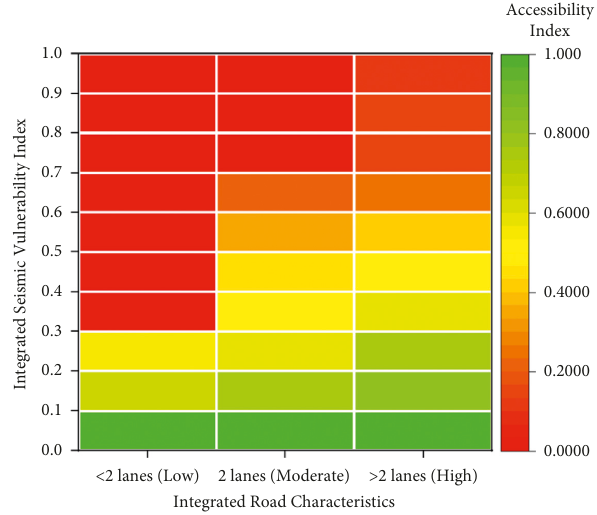
Figure 20: Generated accessibility heat map between integrated road characteristics and integrated seismic vulnerability index for